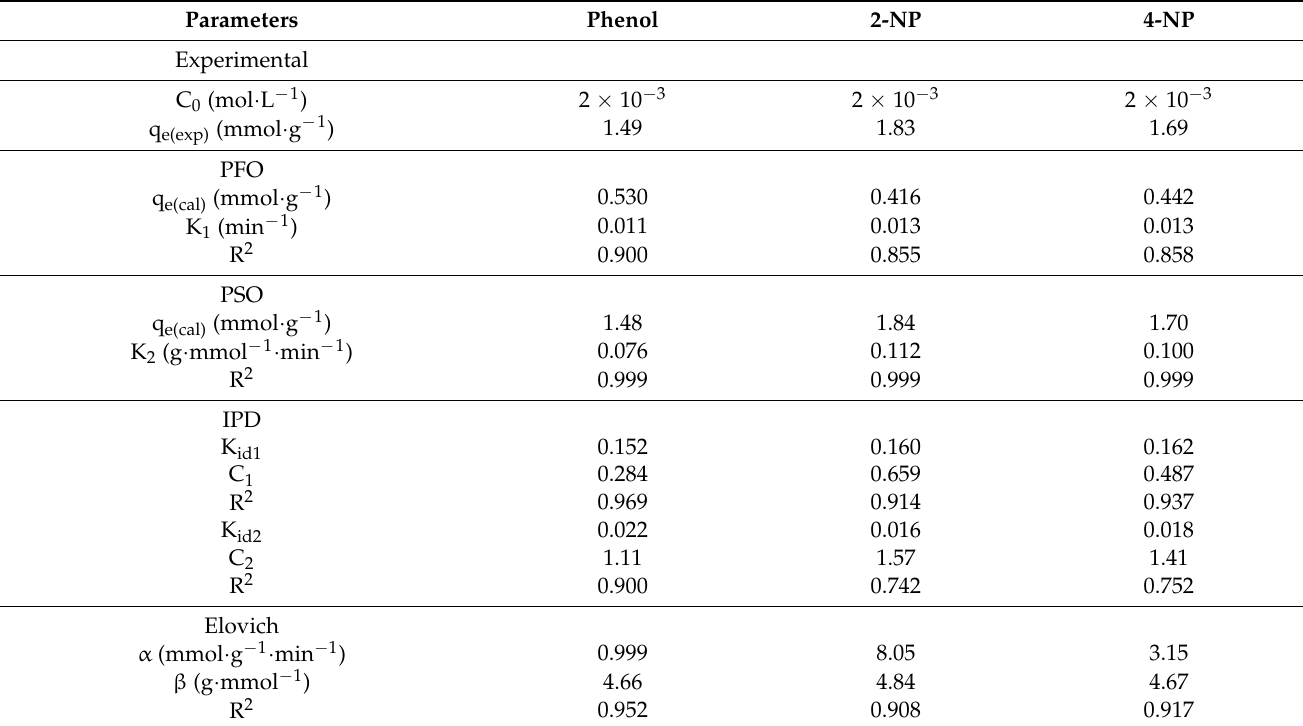
Table 5. Kinetic parameters for the removal of phenol and NPs on